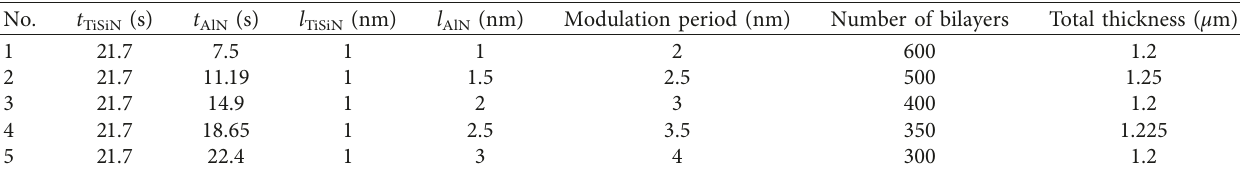
Table 1: Modulation periods of TiSiN/AlN nanomultilayers.